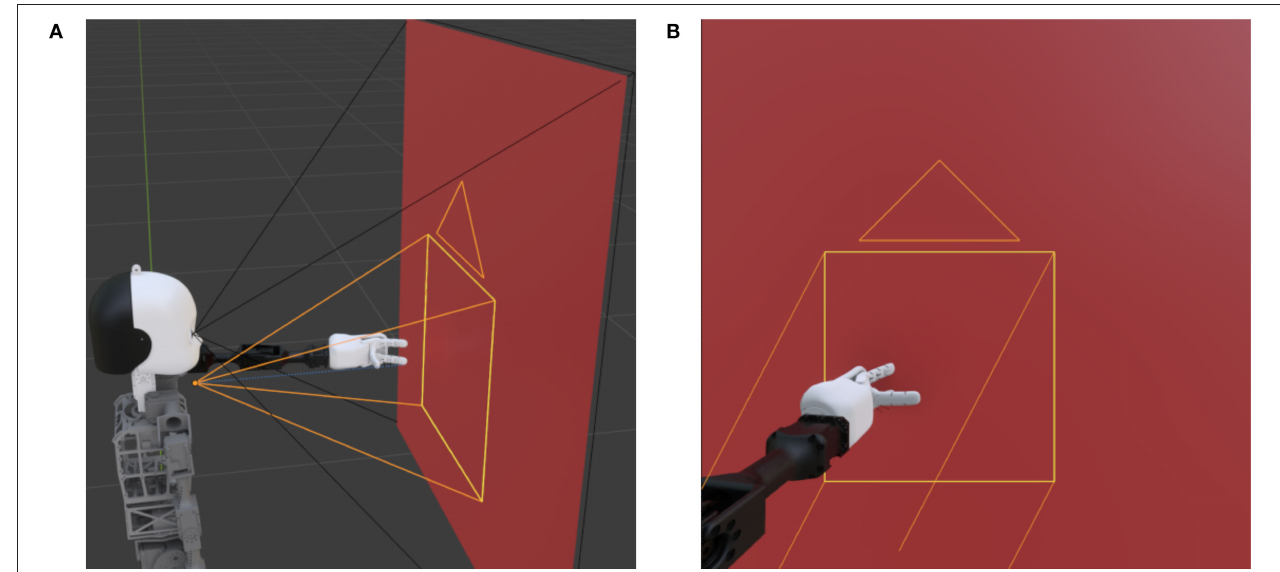
FIGURE 2 | The Blender scenario from two different perspectives. (A) shows the robot, the plane, and the two fields of vision as black and orange lines. While the former lines represent the fixed main camera positioned at the right eye, the latter represent the moving camera focused on the robot’s hand. (B) is showing the perspective of the main